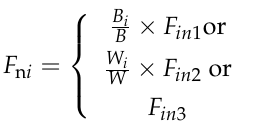
Figure 2. As a result, the sustainability performance of contaminated site risk management was categorized into three levels depending on both the risk value and benefit value, i.e., provide support for scientific decision-making regarding future site